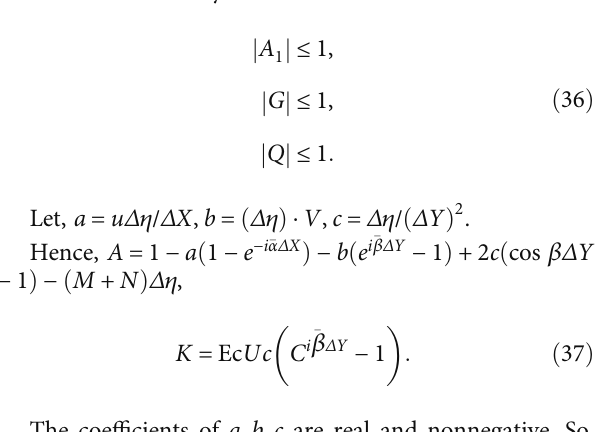
Table 6: Variability of the curve when Y = 1 in Figure 8(c).